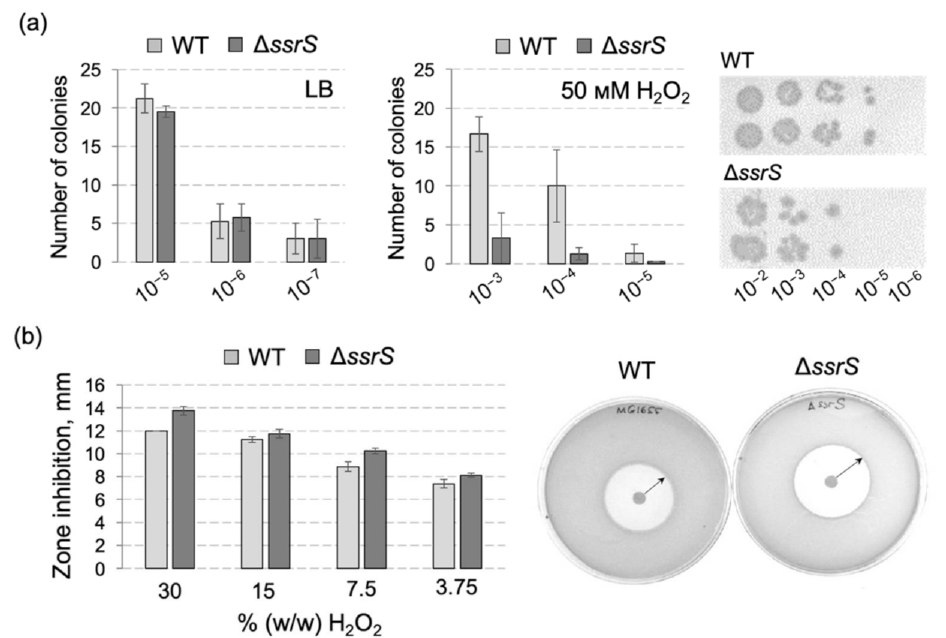
Figure 2. The lack of 6S RNA leads to reduced survival of E. coli MG1655 cells in the presence of H 2 O 2 . ( a ) Results of cell culture plating (serial dilutions indicated on the X-axis) after 30 min of incubation in the absence (left panel; LB control) or presence of 50 mM H 2 O 2 (central panel), 4 biological replicates in each case. A plating example after culture incubation with 50 mM H 2 O 2 is shown on the right. ( b ) Results of the zone of inhibition test for E. coli MG1655 WT and ∆ ssrS bacteria grown in the presence of different H 2 O 2 concentrations (left panel, based on three biological replicates each); corresponding example agar plates are illustrated on the right: after streaking of cell culture dilution, a paper disk (5 mm diameter) soaked with 30% ( w/w ) H 2 O 2 was placed in the center (gray sphere) of the plate; the white area is the zone of no growth whose diameter was measured with a ruler after 24 h at 37 ◦ C; 30% ( w/w ) H 2 O 2 corresponds to 9.79 M, 3.75% to 1.22